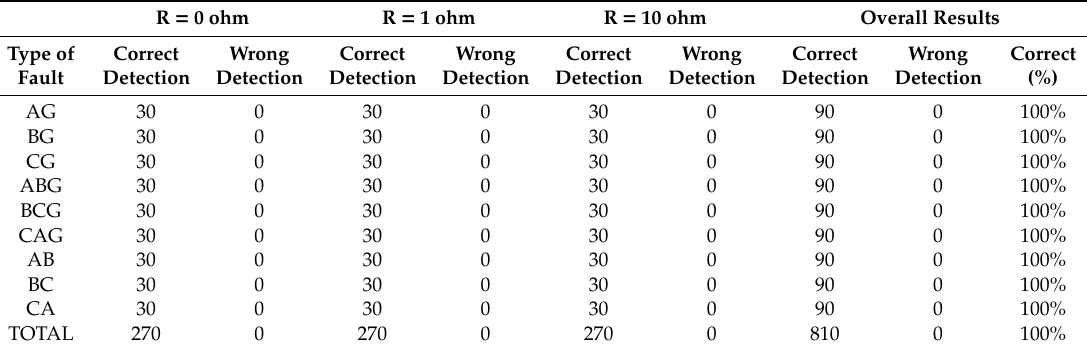
Table 6. Algorithm behaviour. Summary of results obtained for di ff erent faults fed by PV